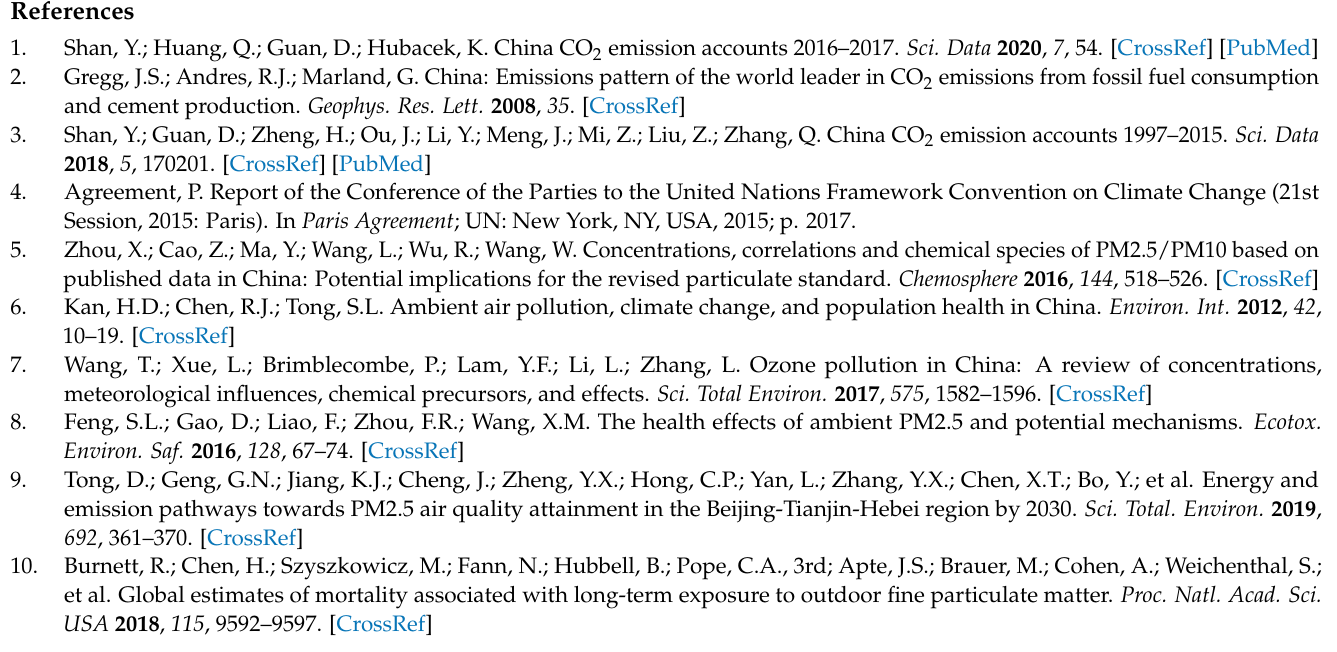
of Guangdong Province. Figure S2. Validation of model performance, unit: µ g/m 3 . The heavy dash line indicates the 1:1 line, while the lighter dashed lines indicate the 1:2 and 2:1 lines. Table S1. The key parameters and assumptions in the IPAC model for the future social development of Guangdong. Table S2. WRF-Chem model